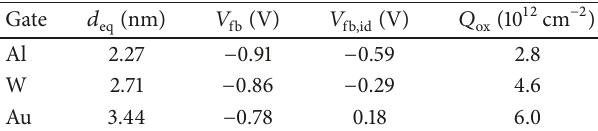
Table 2: Equivalent oxide thickness ( 𝑑 obtained from C-V curves measured at 100 kHz, ideal flat band voltage ( 𝑉 ), and determined oxide charge ( 𝑄 fb , id